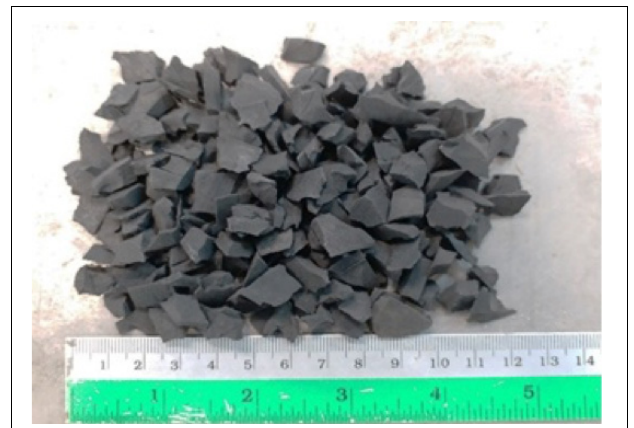
FIGURE 1 | Waste rubber tire